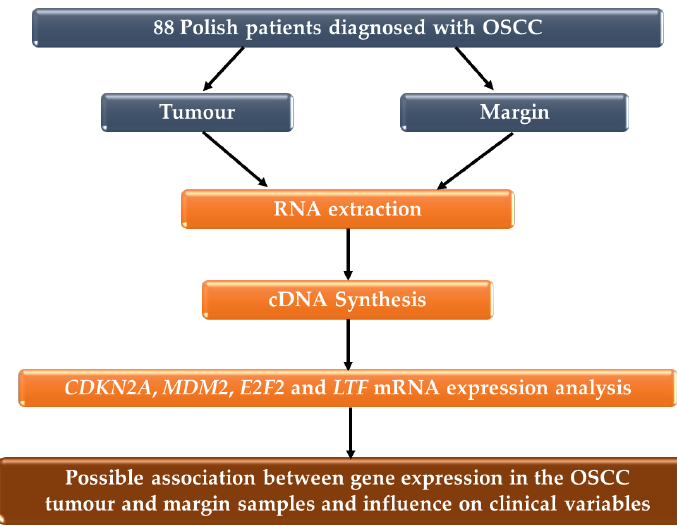
Figure 1. Study protocol diagram.